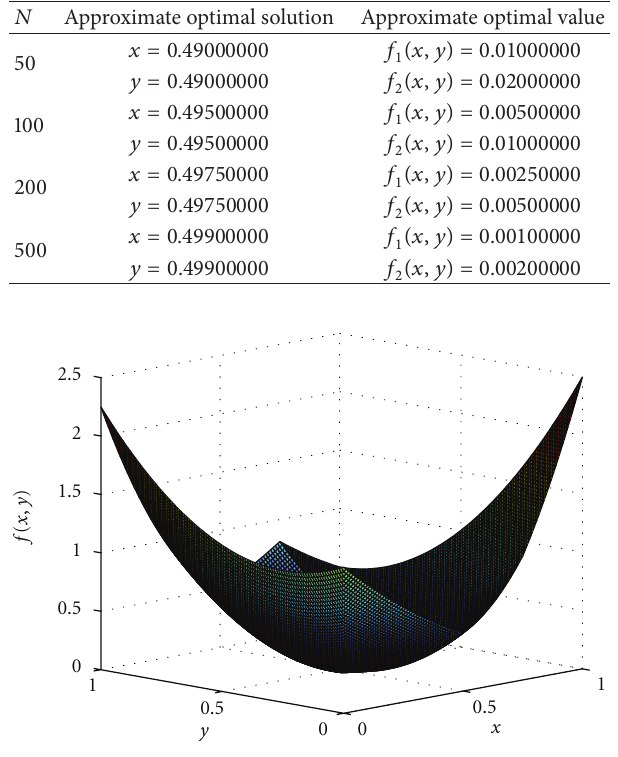
Figure 12: The graph of 𝑓(𝑥,𝑦) of Example